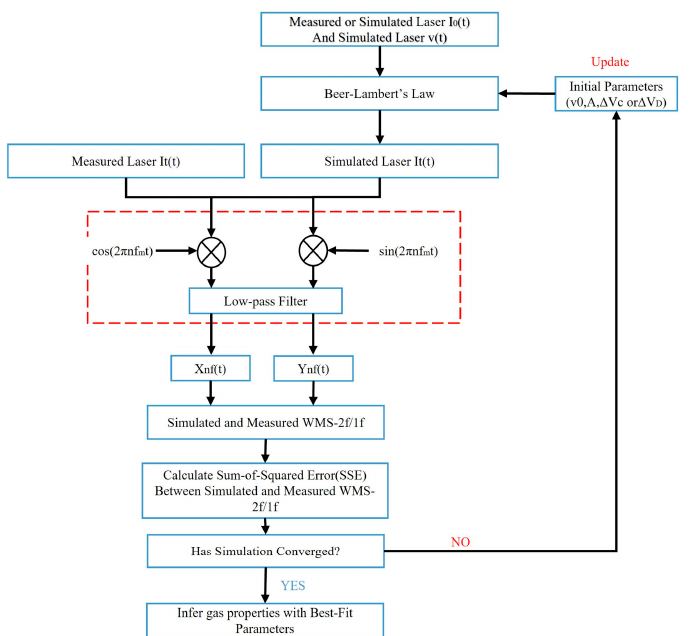
Figure 1. Flow chart of scanned-WMS- 2f/1f spectral fitting routine. The guess values of initial parameters are firstly employed in the iteration. If the SSE is smaller than the predetermined value when the iteration converges, the outputs of the iteration are used to infer gas properties. Otherwise, the initial parameters have to be updated and repeat the iteration.